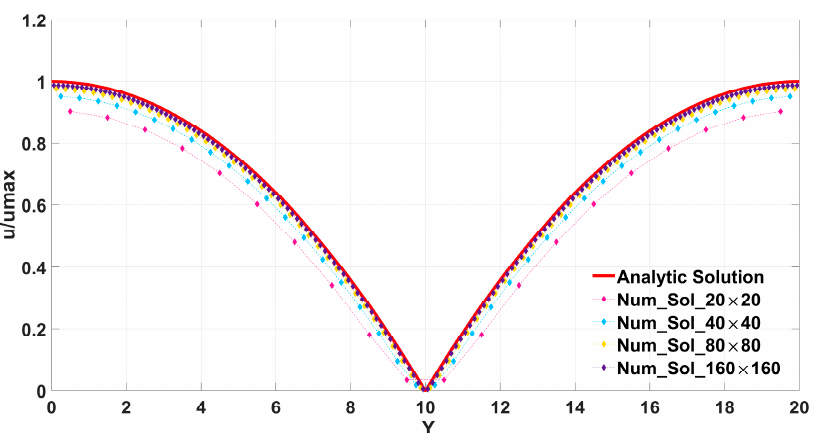
Figure 4. The comparison of the numerical solutions according to the four grid schemes and the analytic solution.